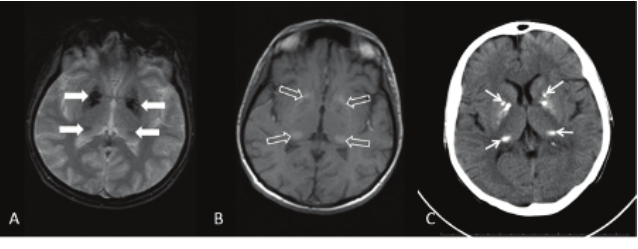
Figure 2 - Case 10: A 52-year-old patient with FAHR disease, calcifications marked with bold white arrows in the dentate nucleus in both cerebellar hemispheres in A, in the lentiform nuclei in the upper part and in the thalamus in the lower part in B, in bilateral periventricular deep white matter in C.